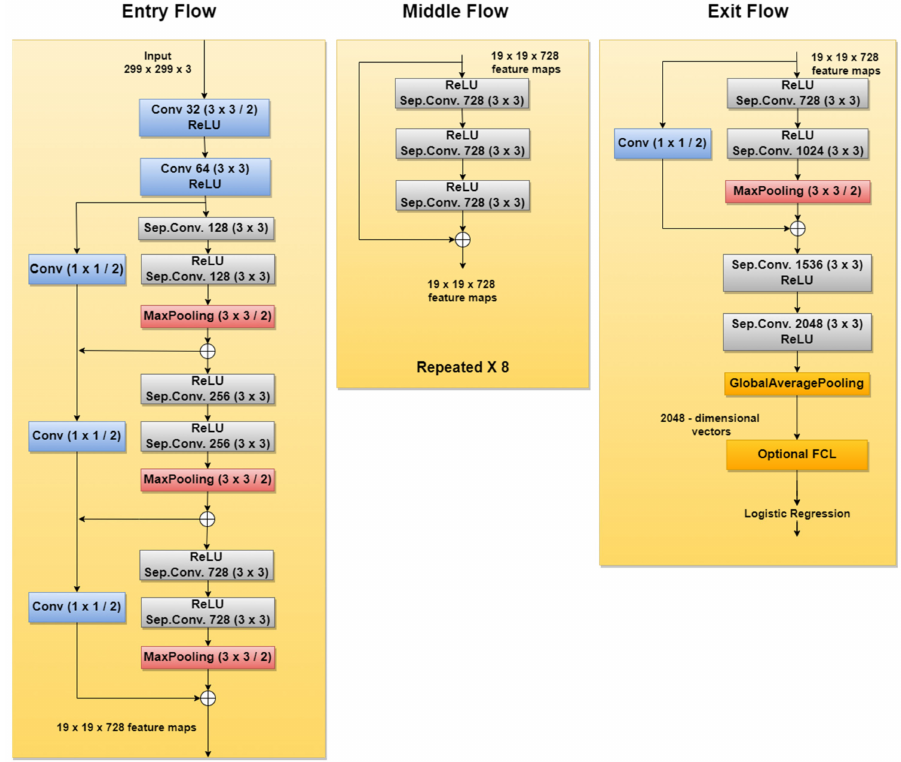
Figure 18. Xception network